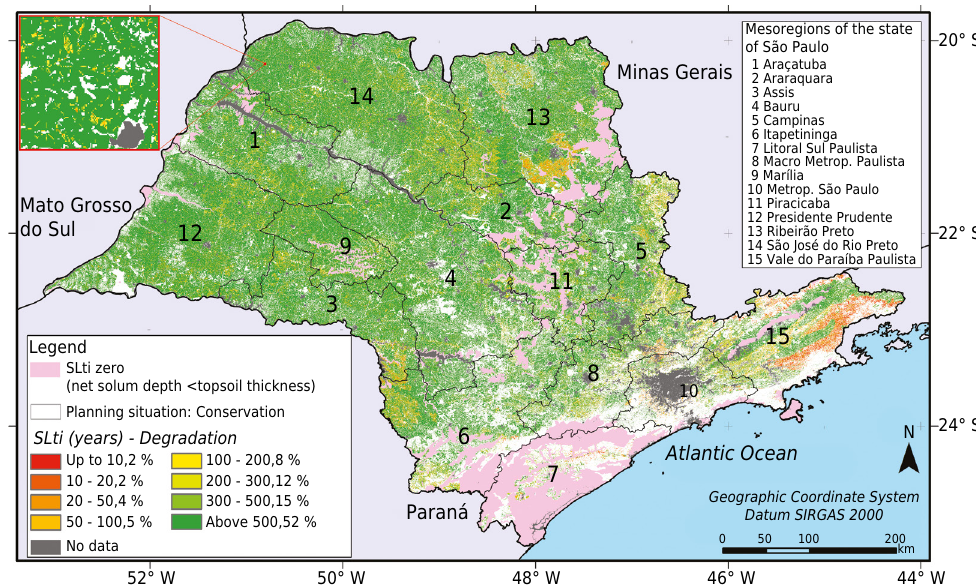
Figure 5. Soil Lifetime Index map of state of São Paulo (critical depth 1